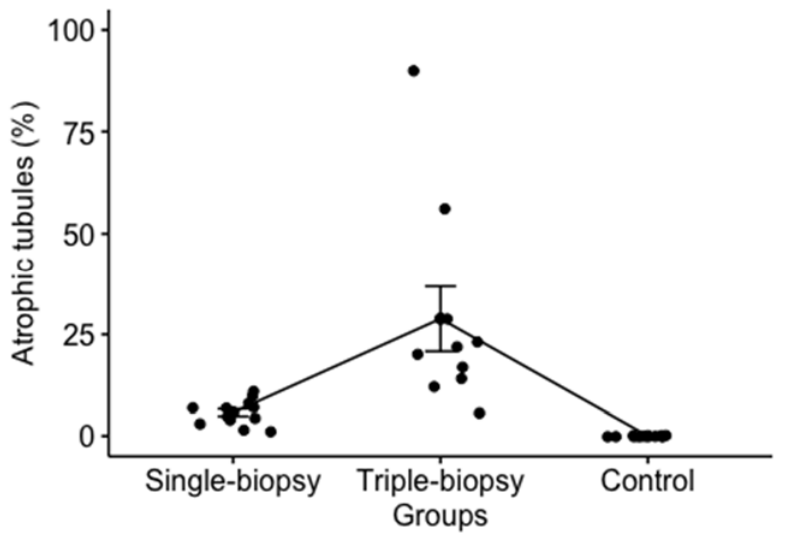
Figure 7. Percentage of atrophic tubules between the experimental groups (Kruskal-Wallis test; p <